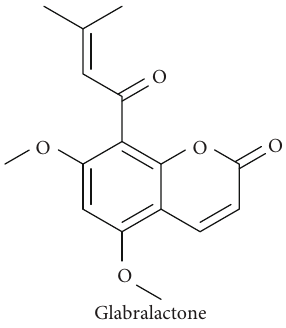
Figure 1: Chemical structure of